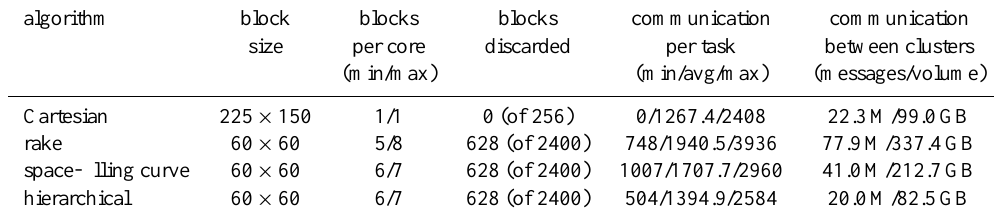
Table 2. Configuration of the Cartesian, rake, and space-filling curve, and hierarchical distributions.